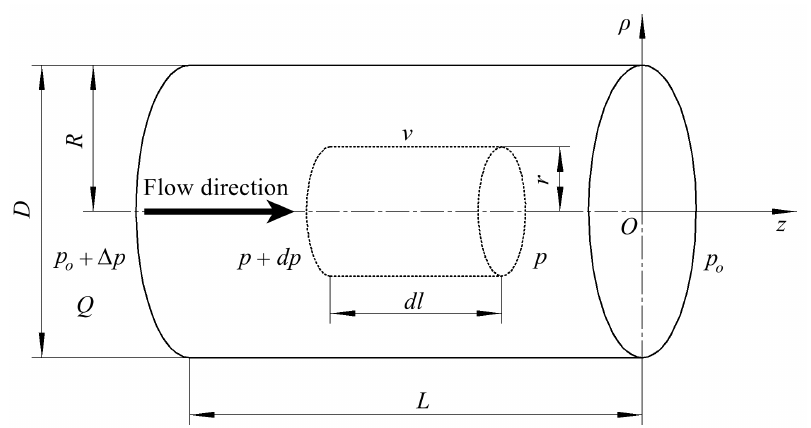
Figure 2. Analysis model of laminar flow in a circular